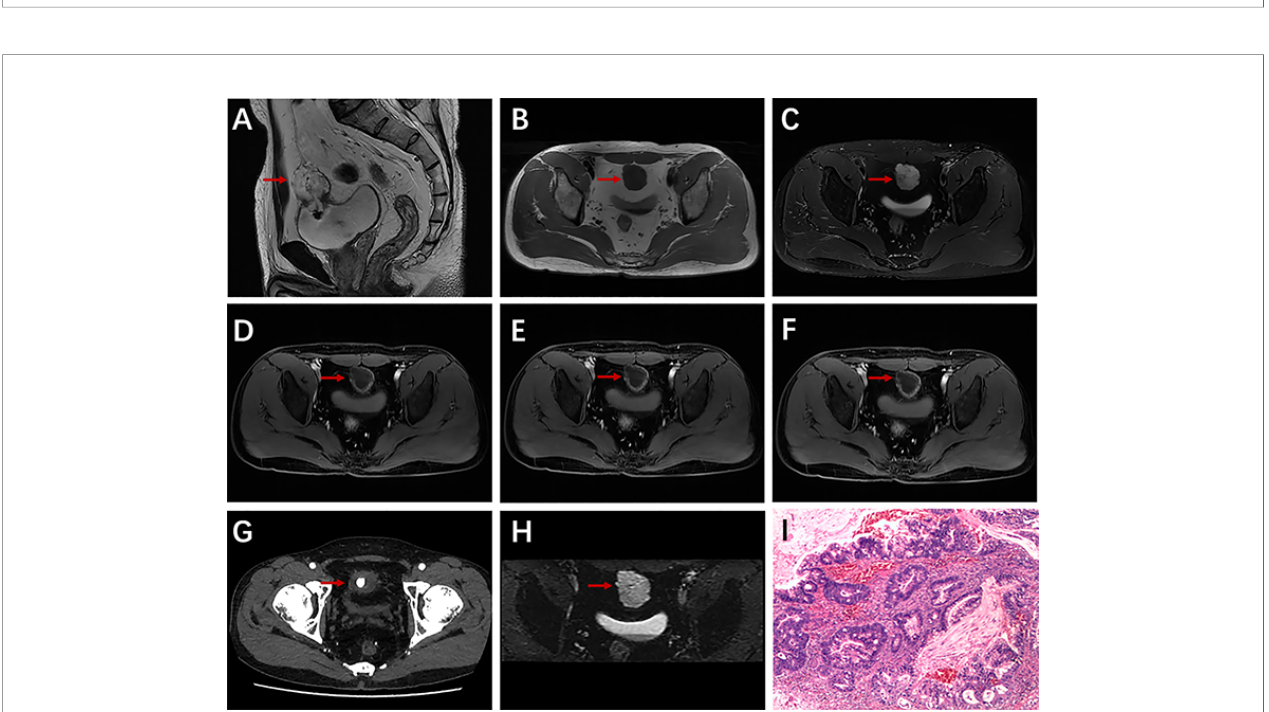
FIGURE 2 | A 43-year-old man with urachal carcinoma presented with painless gross hematuria. Sagittal T2WI (A) showed a solid mass in the urachal region; very low signal intensity on T1WI (B) and very high signal intensity on T2WI (C) ; axial dynamic contrast-enhanced LAVA-Flex images showed apparent ring enhancement (D – F) ; nodular calci fi cation on axial CT scan (G) ; restricted diffusion on DWI (H) ; pathologically con fi rmed urachal adenocarcinoma (intestinal type) (I)